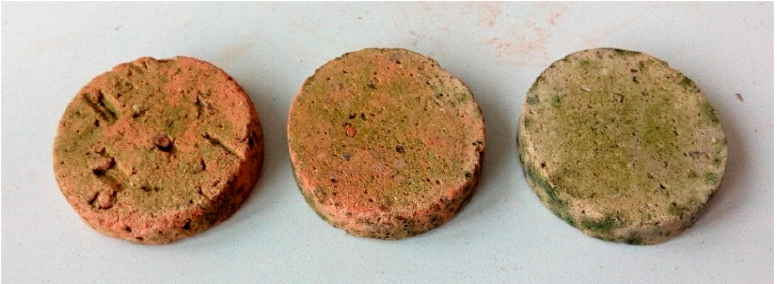
Figure 7. Samples of the Holešov-Žopy bricks covered by a biofilm layer of 0–1 cm, 1–2 cm and 2–3 cm (from left to right).